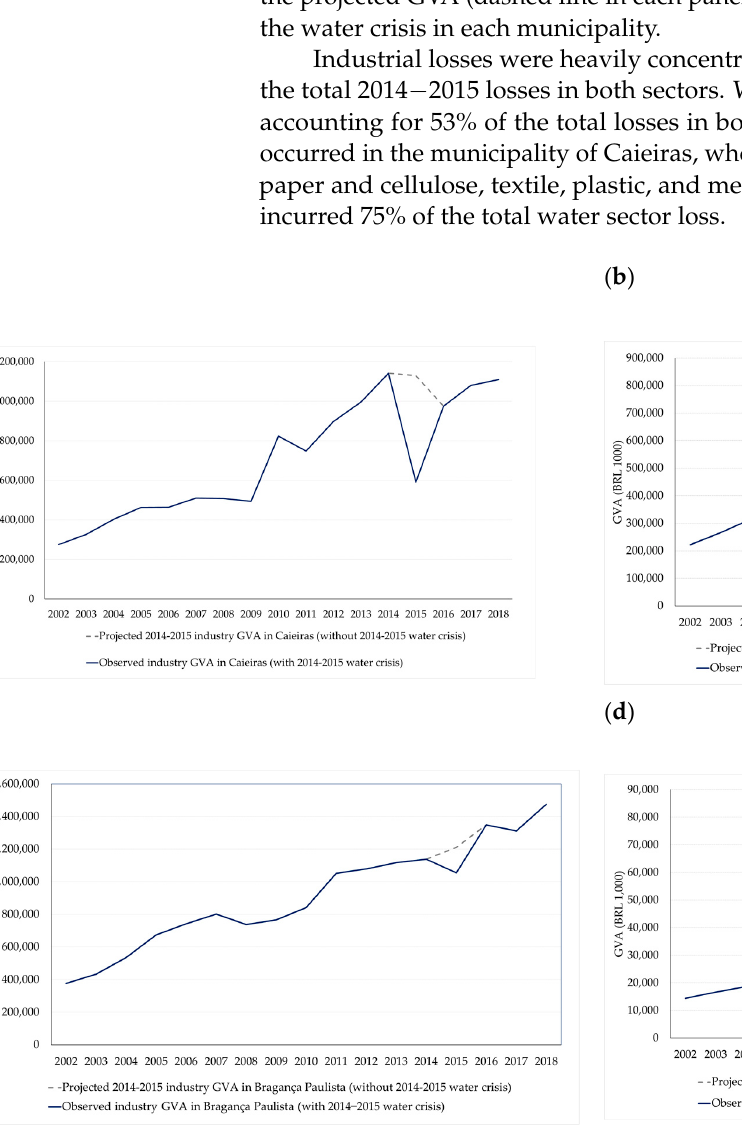
Figure 5. Observed industrial GVA (solid lines) and estimated industrial GVA without the 2014–2015 water crisis (dashed lines) for the municipalities of ( a ) Caieiras, ( b ) Franco da Rocha, ( c ) Bragança Paulista, and ( d ) Nazaré Paulista.